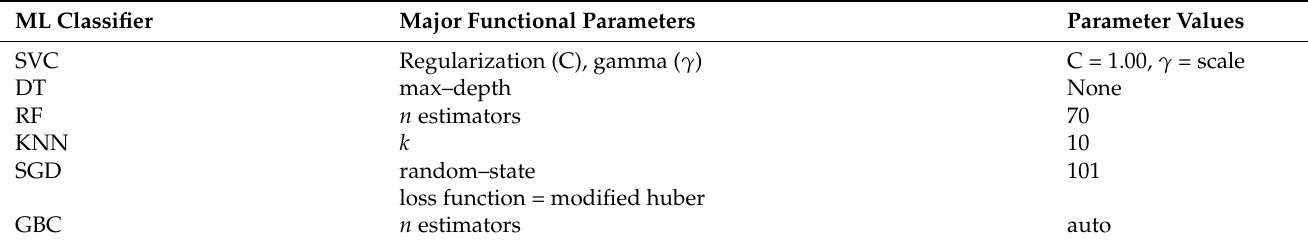
Table 6. The machine learning classifiers models and their various